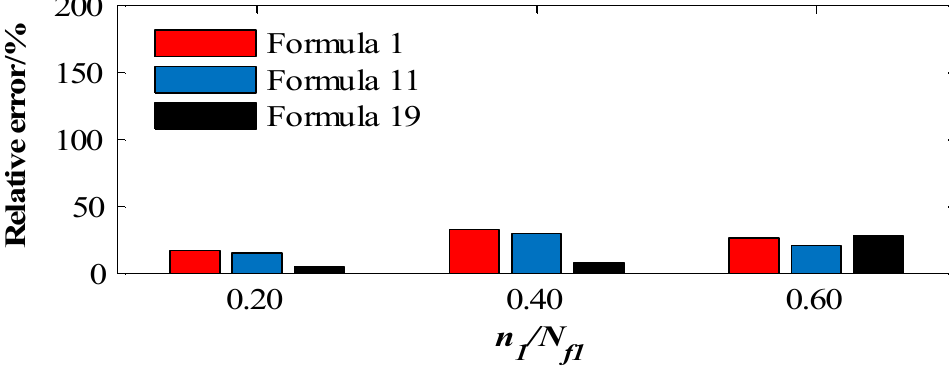
Figure 14. (150–200 MPa) The relative error of each model under different n 1 /N f 1 (Al-2024). It can be seen from Figures 13 and 14, for (Al-2024), under high–low loading, as the proportion of high load continues to increase, the relative error stability of the results ob- tained by the ductile dissipation model is better than that of the Miner’s rule. Under the same conditions, the accuracy of the results from the proposed model is higher than that of Miner’s rule and the ductile dissipation model. Under low–high loading, the results of each model are relatively stable. The accuracy of the improved model is the highest.